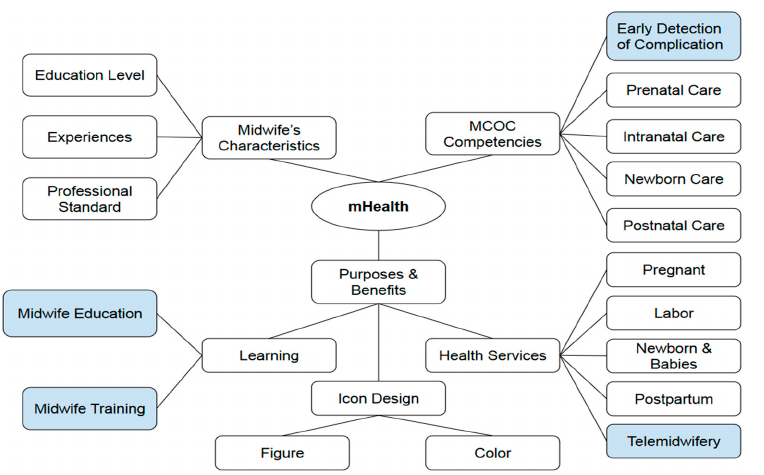
Figure 1. Competence needs in the MCOC mHealth for midwives education (for initial knowledge), training (for strengthening the understanding with skills), and services. Recent findings of qualita- tive results marked with blue color.